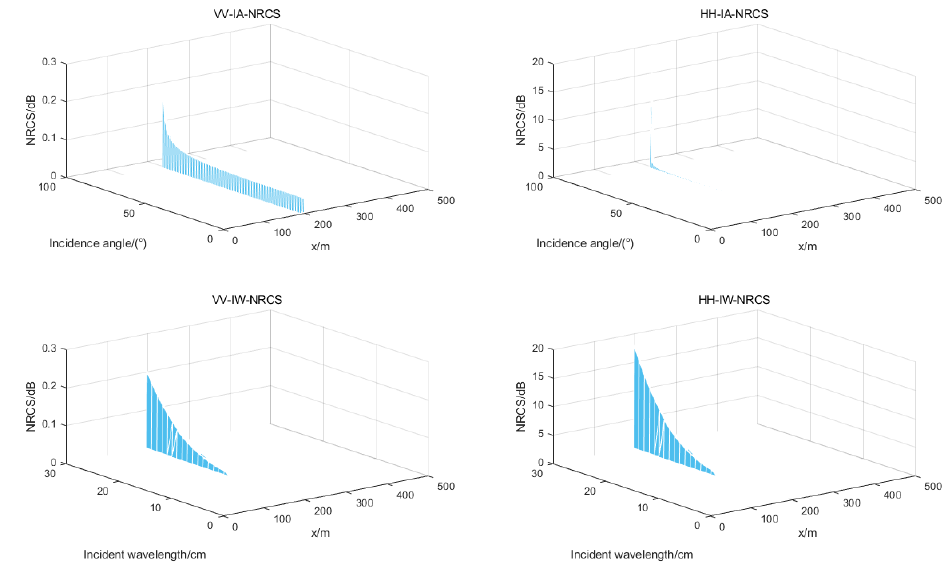
Figure 11. Variation of the difference value of NRCS with incident angle (IA) and incident wavelength (IW) under two polarization modes.